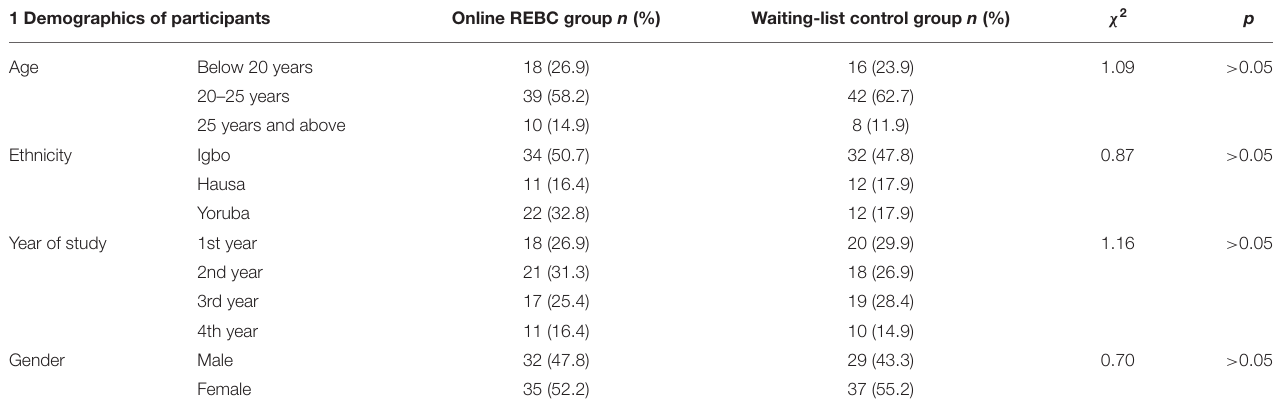
TABLE 1 | Socio-demographic profile of the students.